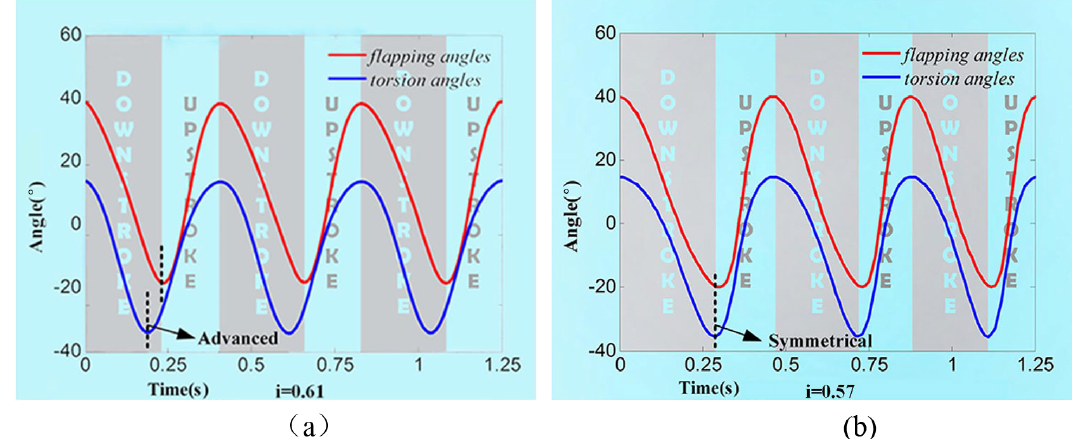
Figure 4. Kinematic characteristic curve of flapping angle and rotation angle. (a) Pre-optimization simulation and (b) optimized simulation.